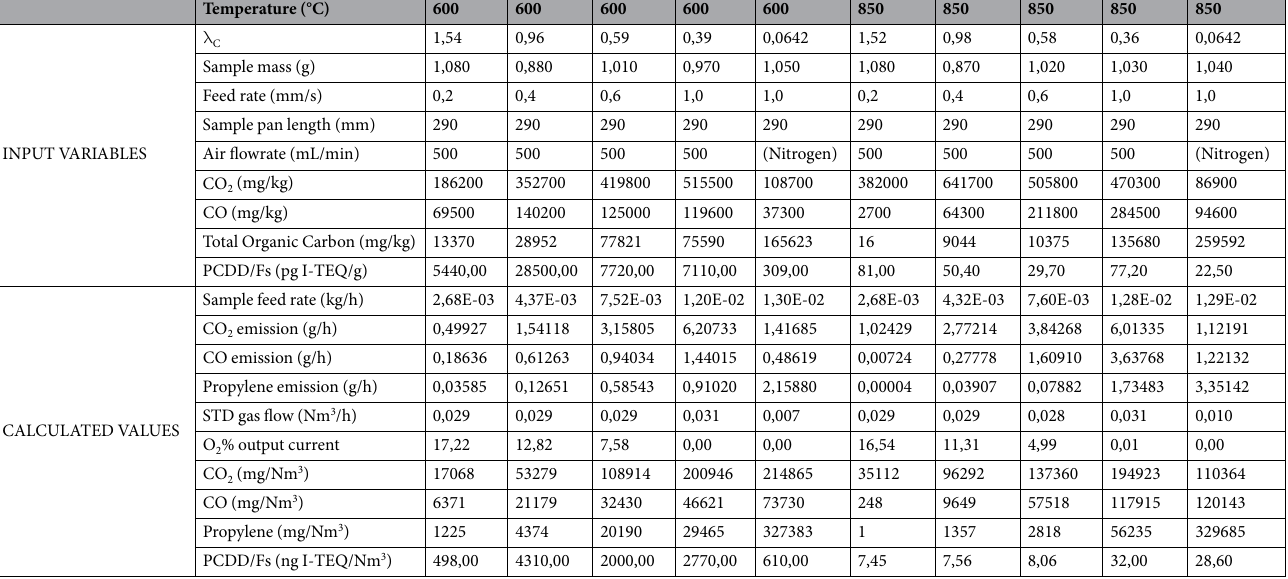
Table 1. Conditions of the runs, measured parameters used for simulation of ASR decomposition and calculated emission levels.